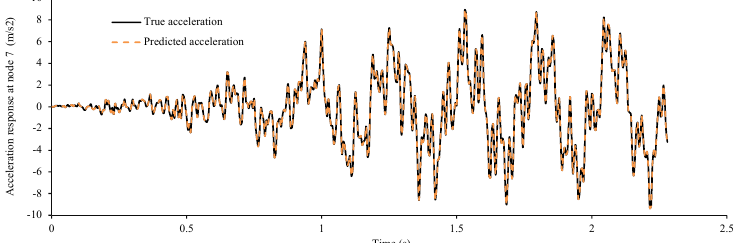
Figure 6. True and predicted acceleration time histories at 0% noise (speed 15 m/s and road roughness level C). Table 7. Identification results from different road roughness levels and vehicle speeds.